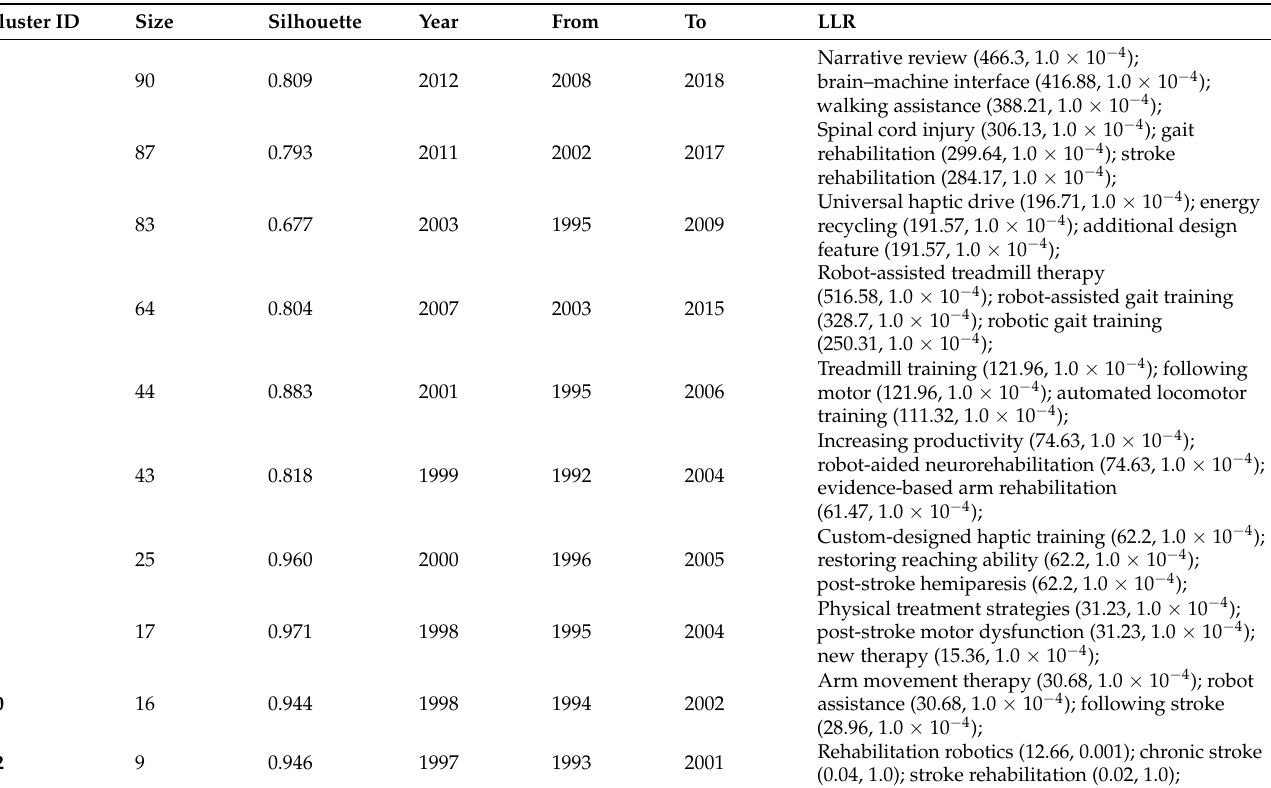
Table 3. Top 10 clusters in the document co-citation